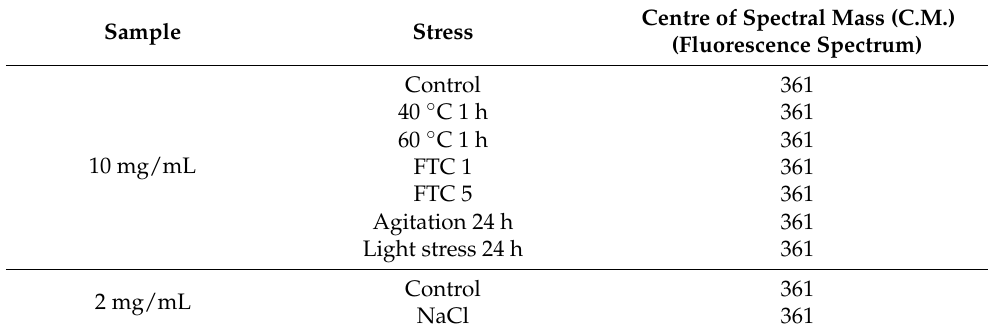
Centre of Spectral Mass